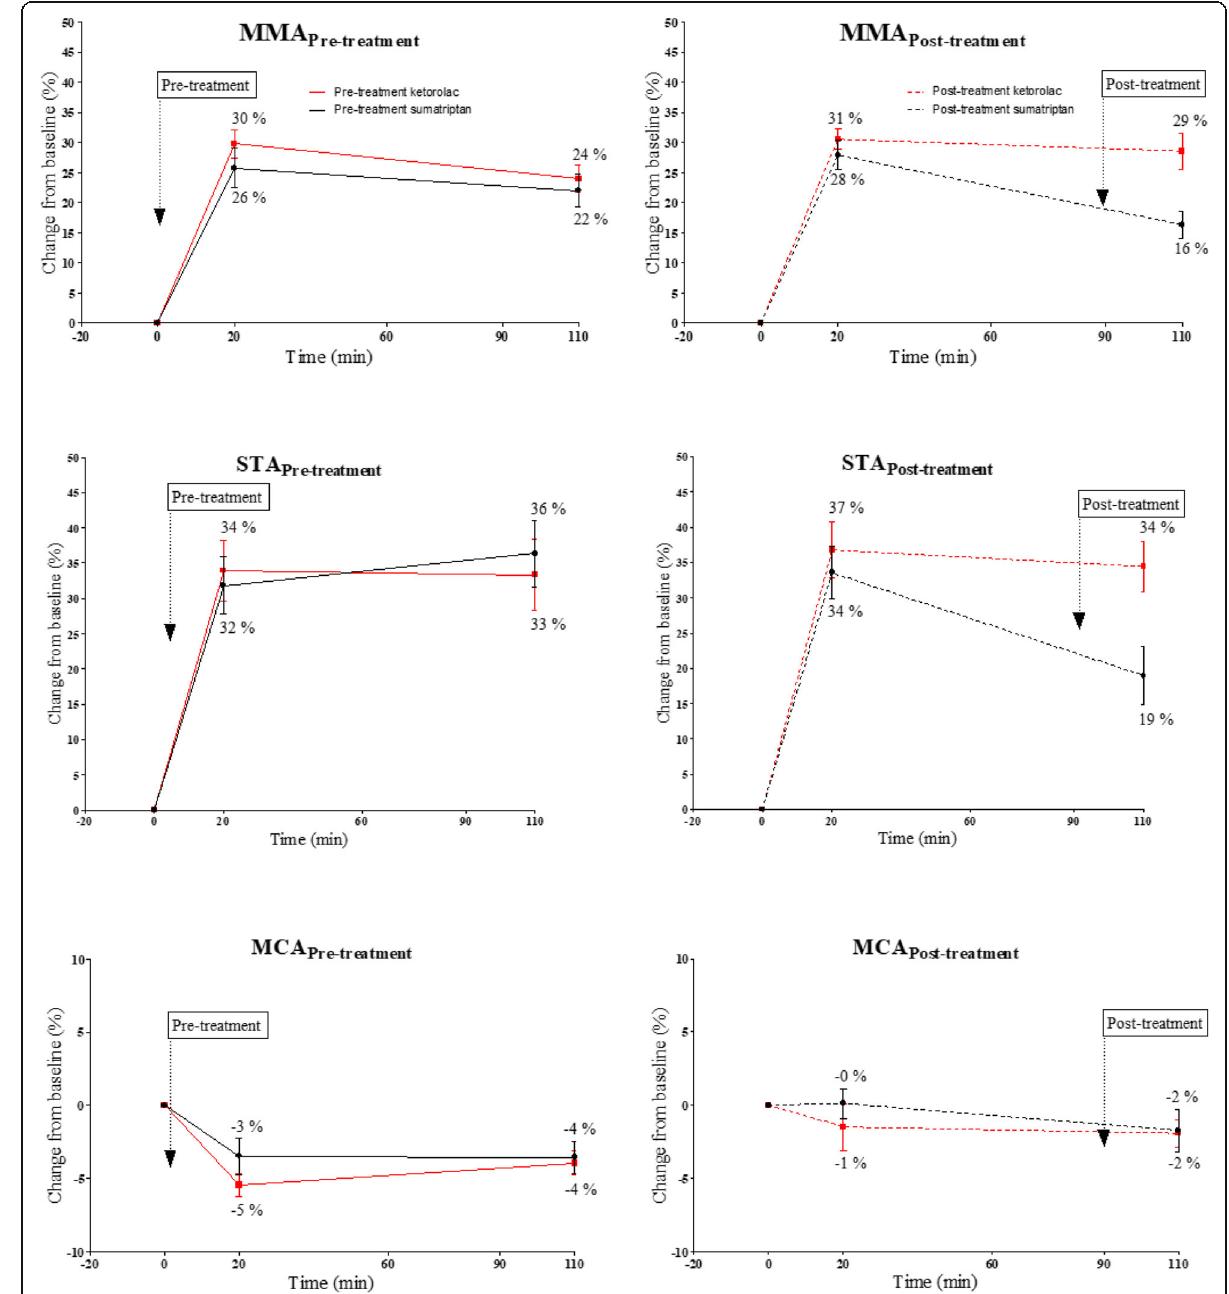
Fig. 3 Effect of pre-treatment (solid line) and post-treatment (dotted line) on extra-intracerebral arteries dilated with PACAP38. Middle meningeal artery (MMA), superficial temporal artery (STA) and middle cerebral artery